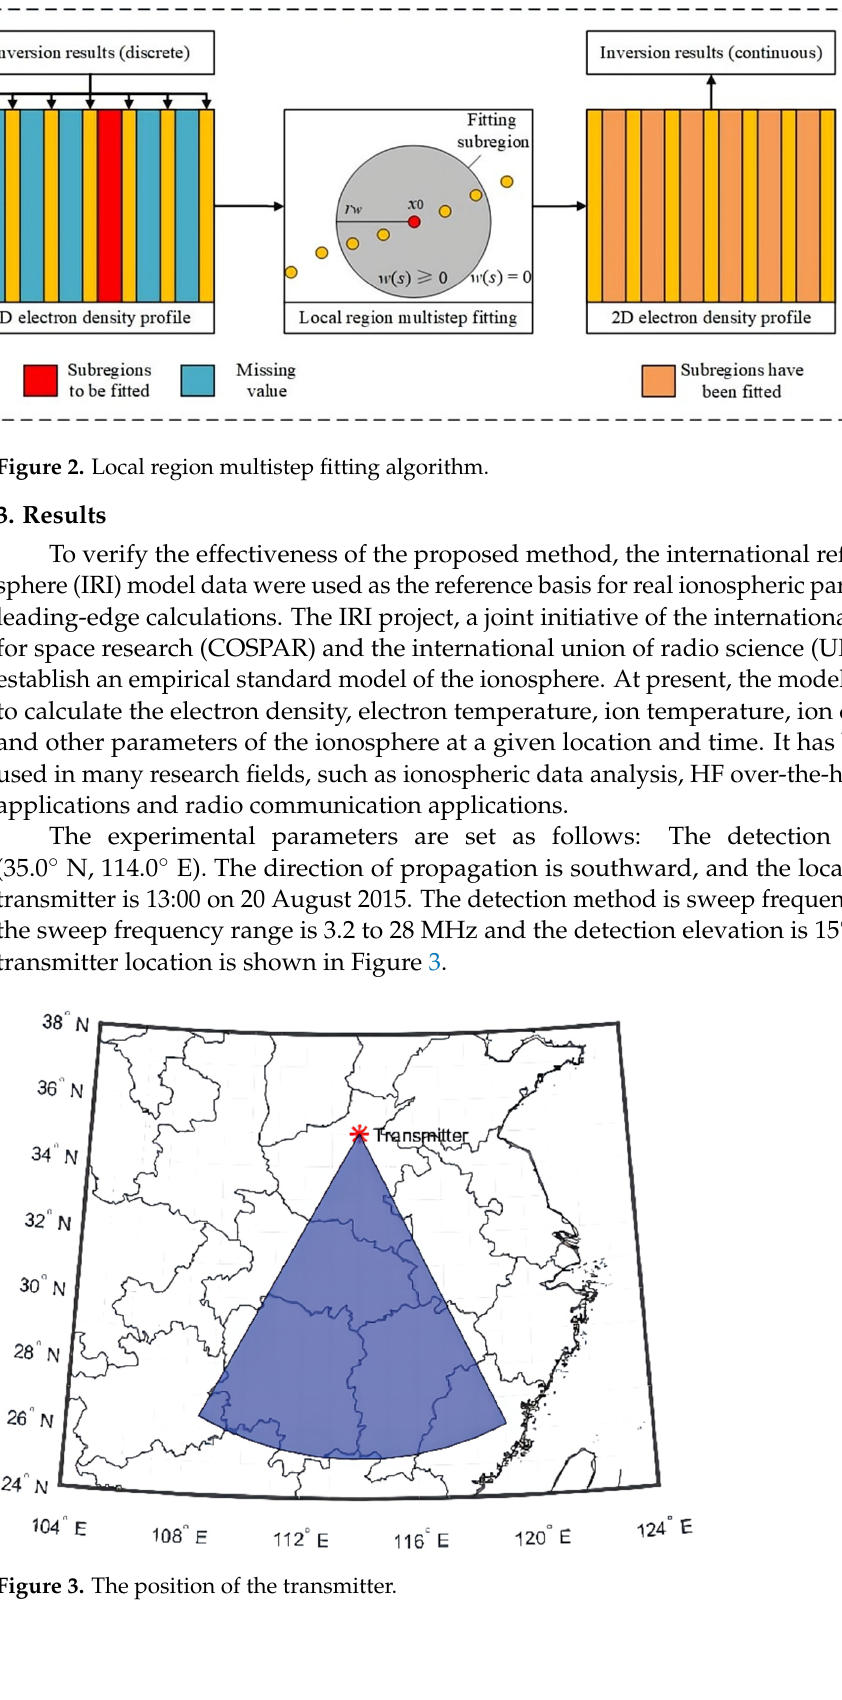
Figure 3. The position of the transmitter. The population number of GA